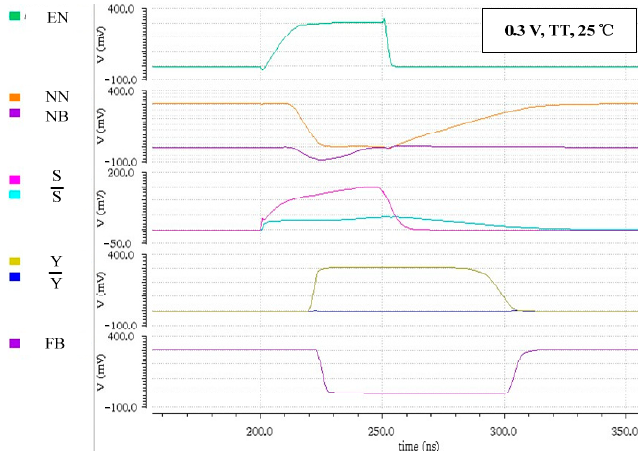
Figure 2. The simulated waveform of the BSA circuit.